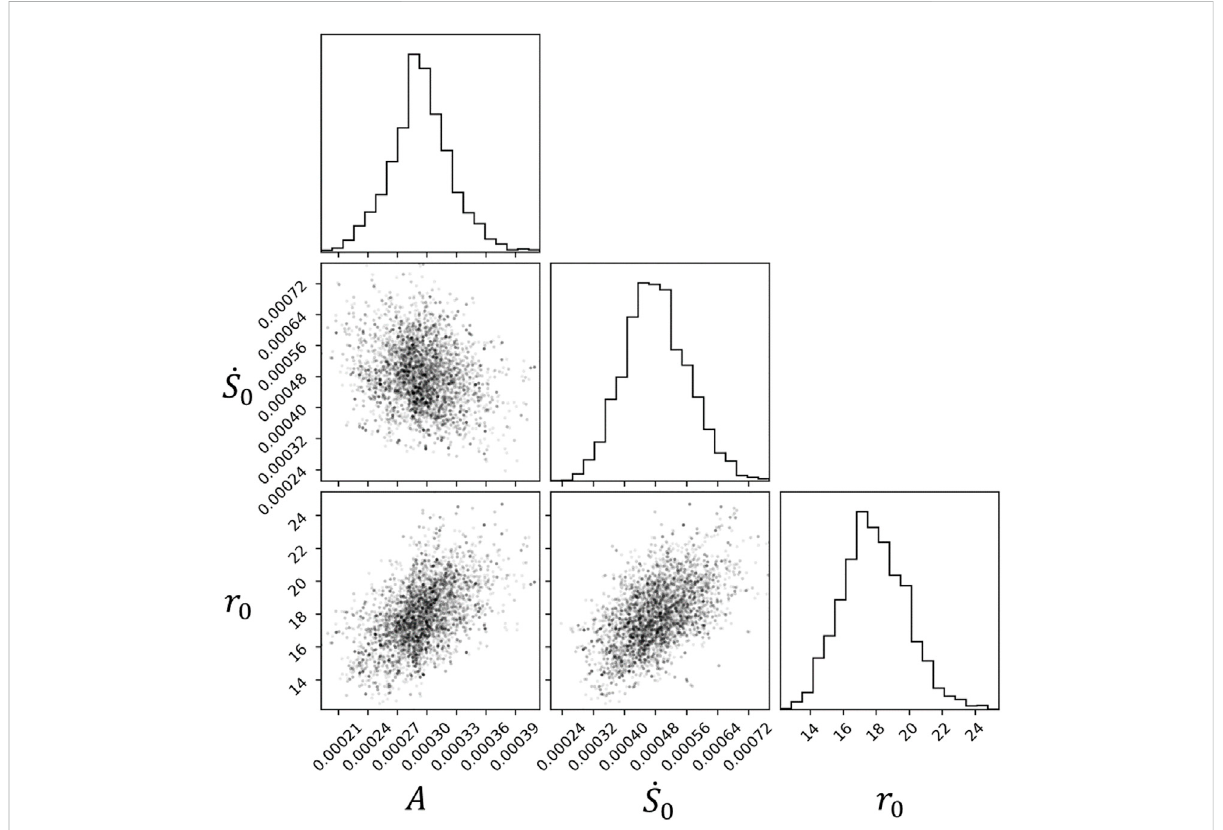
Posterior probability distributions of the seismicity rate model parameters obtained after the data assimilation procedure with the MCMC search. Histogram-type plot: marginal probability distribution of each individual parameter A (left), _ S 0 (centre), r 0 (right). Cloud of points: joint probability distribution of each pair of model parameters A - _ S 0 (top-left), A - r 0 (bottom-left), r 0 - _ S 0 (bottom-right). Note that the prior probability distribution(notshownonthis fi gure)ofeachmodelparameterwasboundedanduniformsuchas: A (-):U(1 e − 5 ,1 . 0), _ S 0 (MPa/year):U(1 e − 7 ,1 . 0), r 0 (event/year): U(0 . 001, 2 e 5 ) — with U(a,b) is a uniform distribution between a and